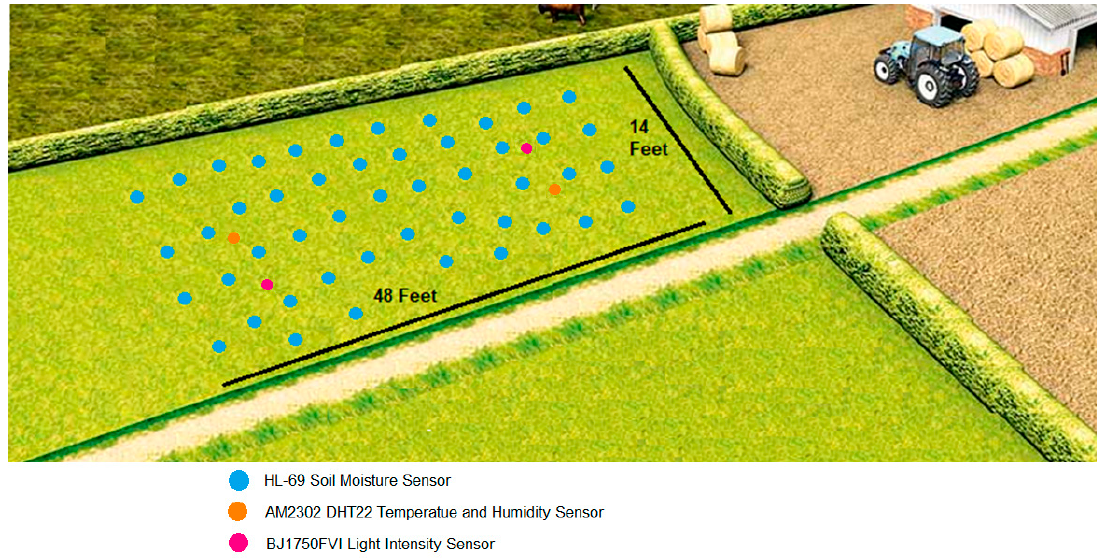
Figure 8. A tunnel form of 14 × 48 feet planned with smart irrigation.